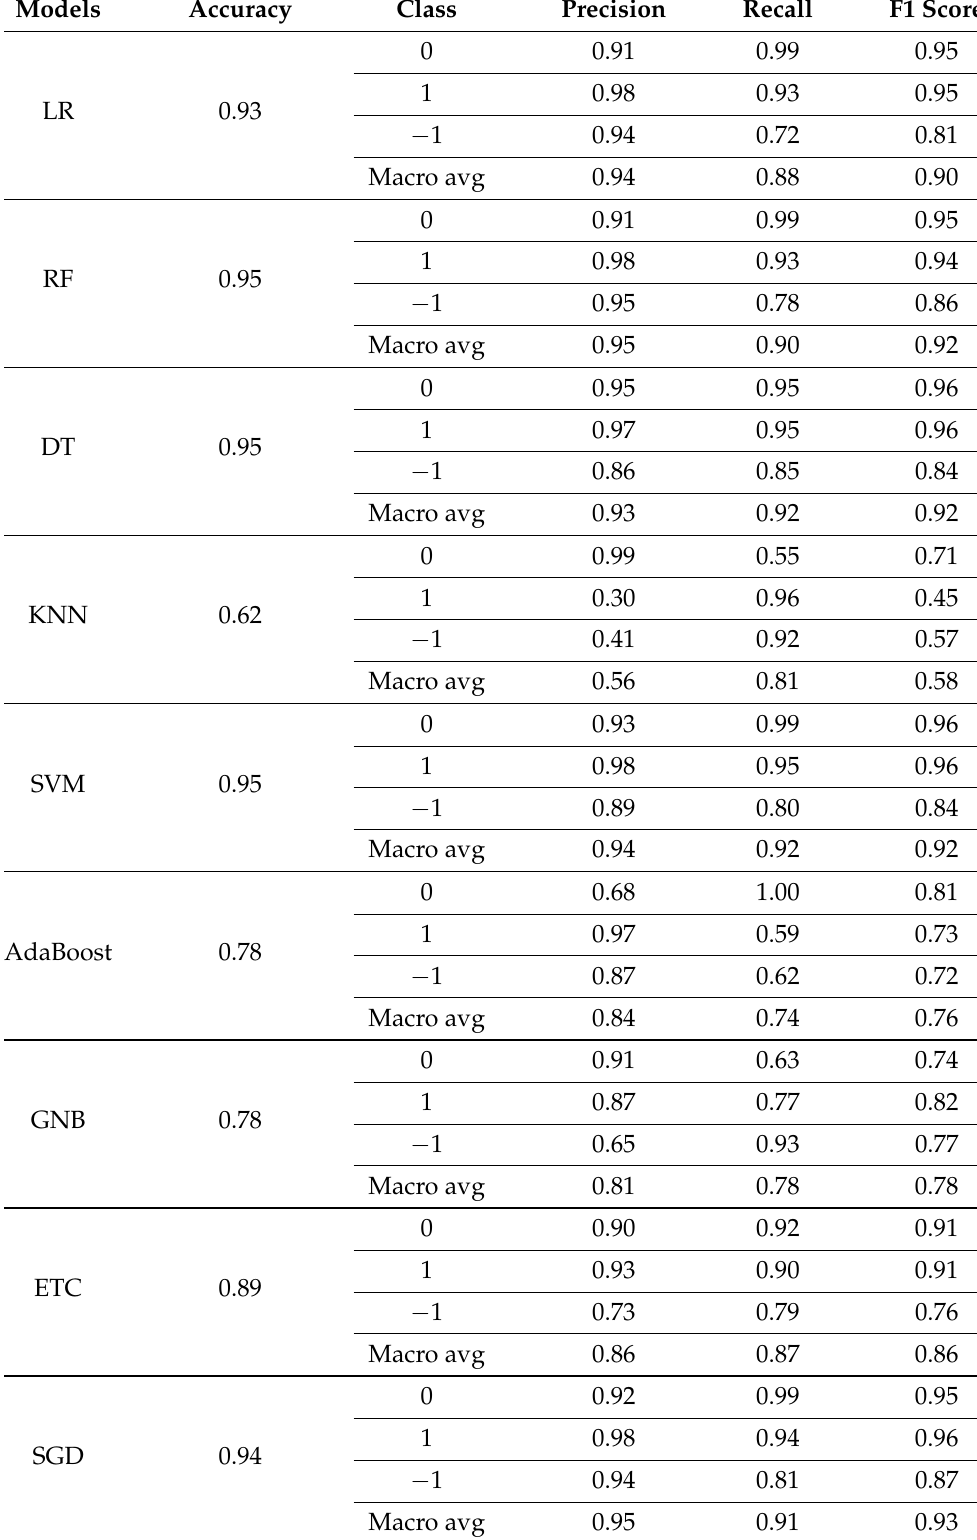
Table 11. Results using BoW features and the SMOTE